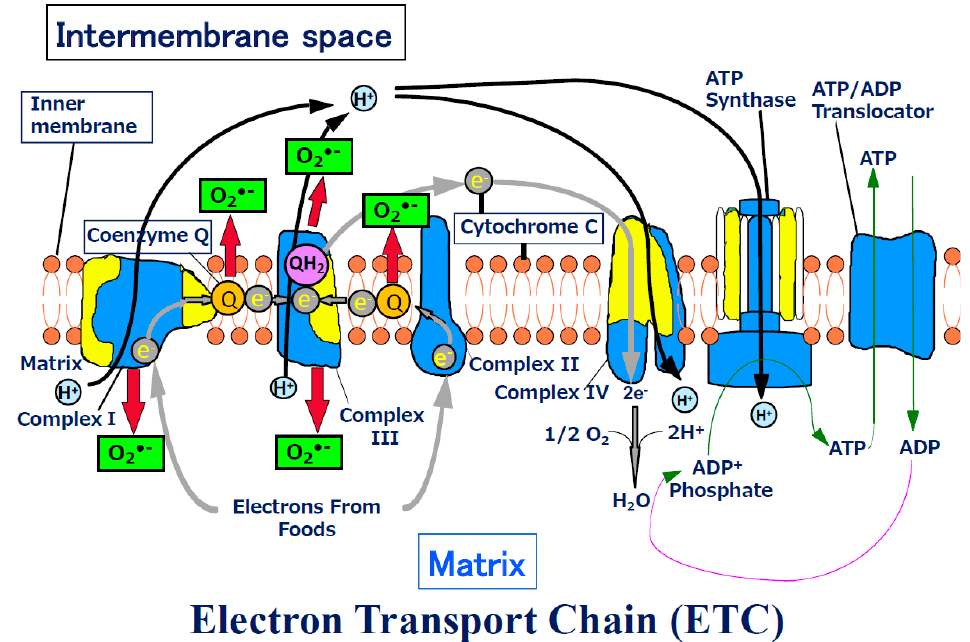
Figure 1. Schema of Electron Transport Chain. ATP production by oxidative phosphorylation with an electron transport chain (ETC). The ETC is composed of over 90 subunits. Among the subunits, yellow parts are the subunits those are translated by the genes in mitochondrial DNA. NADH and FADH2 carry protons (H + ) and electrons (e − ) to the electron transport chain located in the inner membrane. The energy from the transfer of electrons along the chain transports the protons across the membrane and creates an electrochemical gradient. As the accumulating protons follow the electrochemical gradient back across the membrane through an ATP synthase complex, their movement provides energy for synthesizing ATP from ADP and phosphate. At the end of the electron transport chain, two protons, two electrons, and half of an oxygen molecule combine to form water. Then 2–3% of electrons leak from ETC, and oxygen traps the electrons and become superoxide (O 2 •− ). O 2 •− can change its form to become various reactive oxygen species (ROS) in mitochondria .